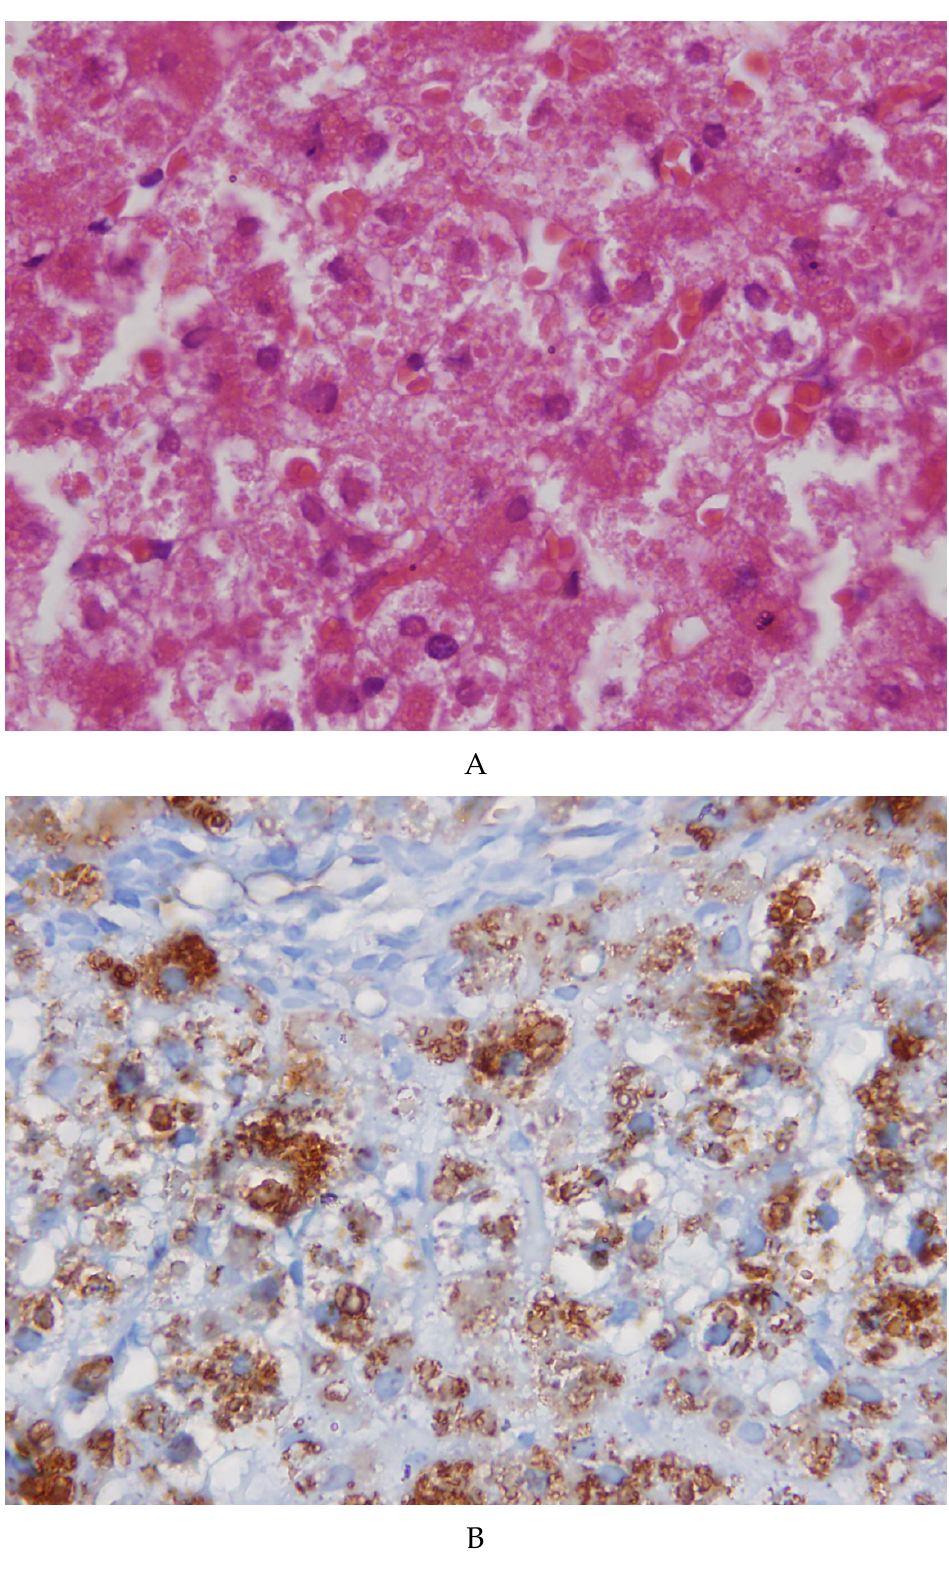
Figure 1. ( A ) Sections from the patient’s liver biopsy. The microphotograph shows a normal lobular architecture with no inflammation or necrosis. Hepatocytes contain round eosinophilic inclusions at times surrounded by a clear halo ( × 40). ( B ) The inclusions show a strong positivity for fibrinogen on immunostaining ( × 20).